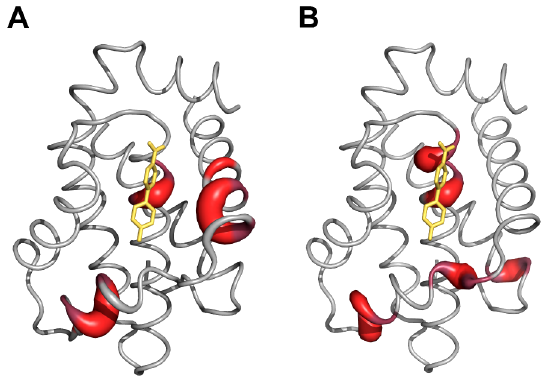
Figure 5. NMR evidences of Bcl-xL conformational change upon fragment binding. (A) CSP H analysis. Significant differences between experimental and simulated CSP H mapped onto the protein surface ( D CSP H -CSP H D § 0.06 ppm). (B) RDC analysis. Residues with D RDC exp -RDC calc D w 6.5 Hz are